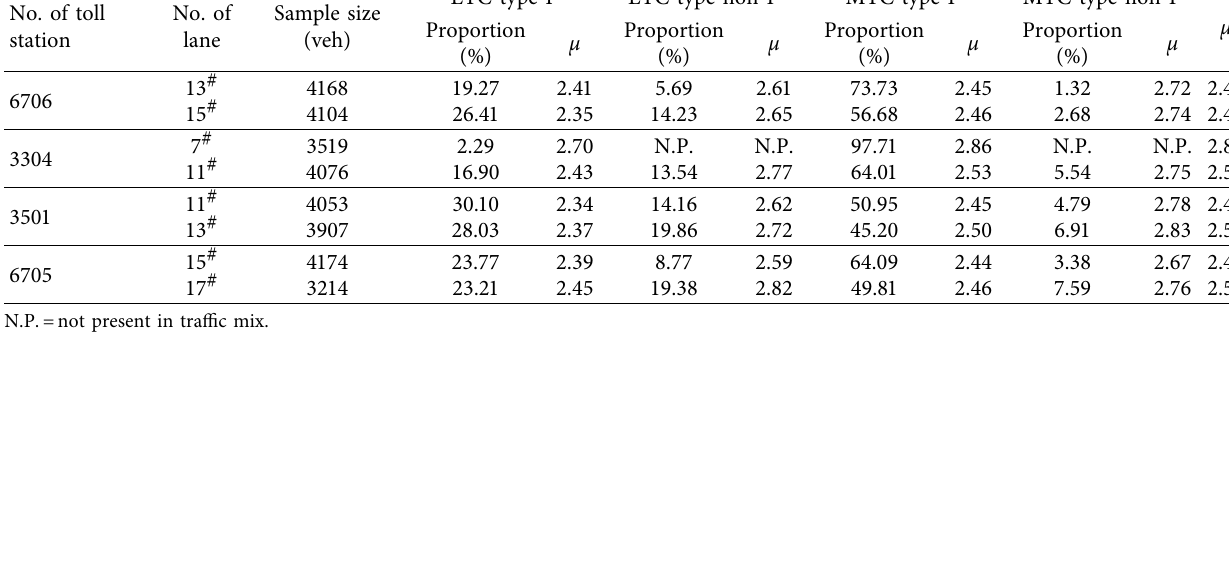
Table 5: Fitting parameters for the lognormal distribution of service time when ETC/MTC entrances of toll stations are saturated. No. of